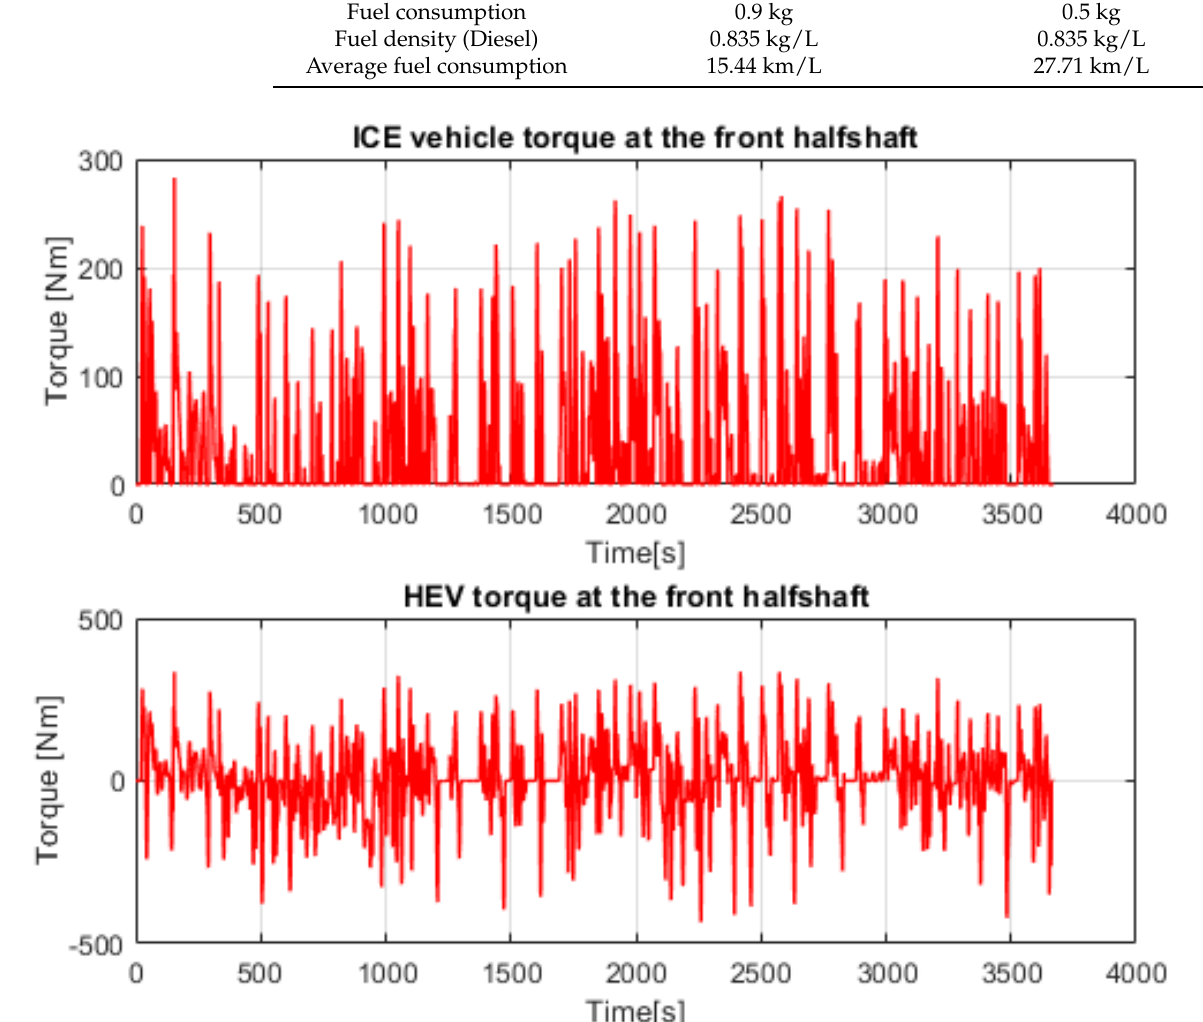
Figure 14. Torque history at the front half-shaft for both configurations.